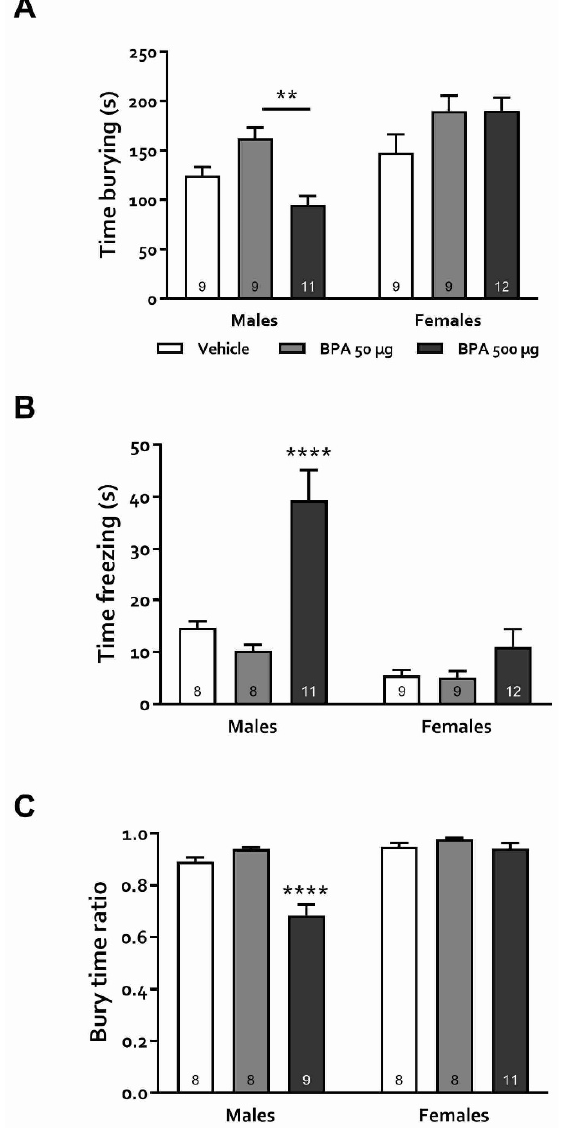
Figure 6. Effects of BPA on active and passive-coping behaviors in DBT. ( A ) Cumulative time spent on burying behaviors. ( B ) Time spent on freezing behavior. ( C ) Bury time ratio: proportion of time spent burying vs. total time spent burying + freezing. Results are shown as mean ± SEM. Numbers within bars indicate animals per group. **: p < 0.01; ****: p < 0.0001 vs. male vehicle group.